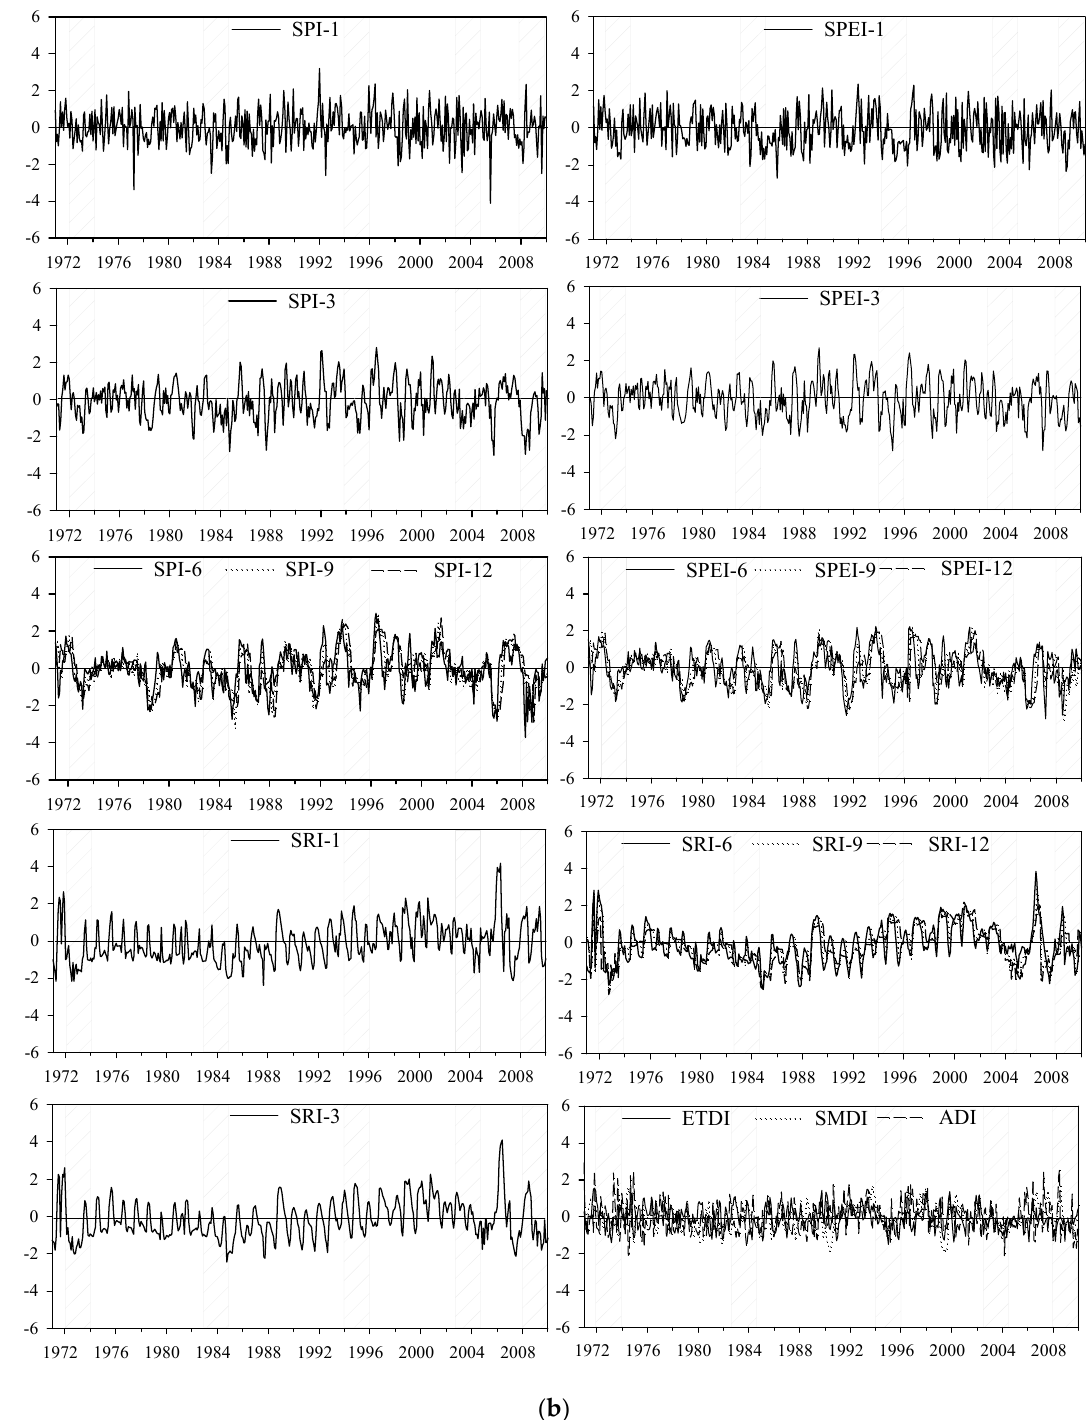
Figure 2. The time series plots of the drought indices for Gondar ( a ) and Debremarkos ( b ) stations. The plots for Standardized Precipitation Index (SPI), Standardized Precipitation Evapotranspiration Index (SPEI), and Standardized Runoff Index (SRI) at 6-, 9-, and 12-month time scales are shown